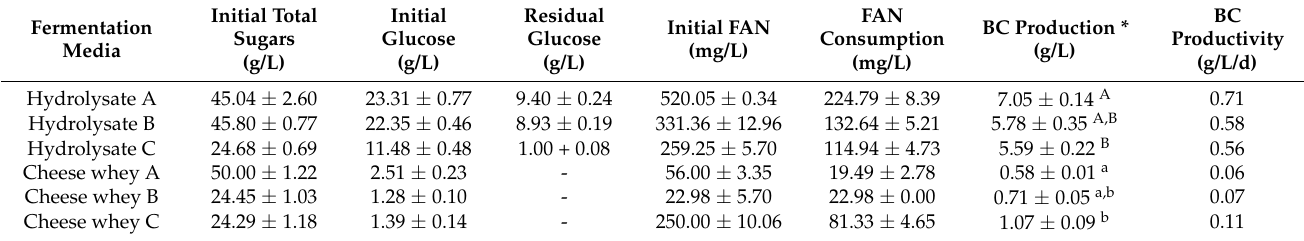
Table 1. Experimental schemes of cheese whey and cheese whey hydrolysates fermentation by A. xylinum . Fermentation